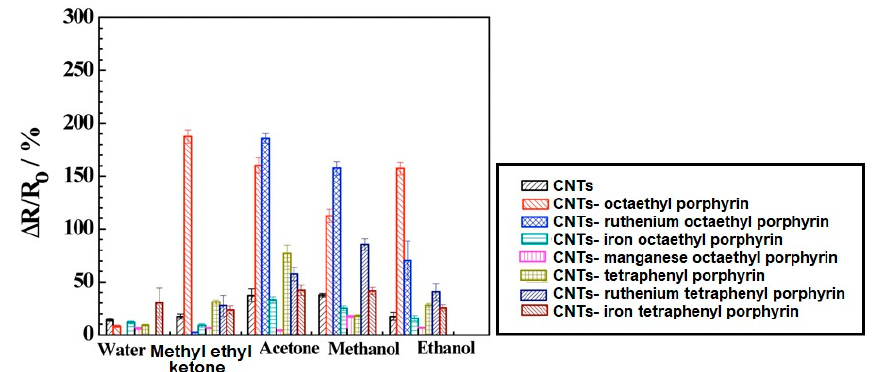
Figure 3. Comparison of carbon nanotubes (CNT) and various CNT-porphyrins hybrids responses towards different gases and water. Reprinted with the authors’ permission [21].